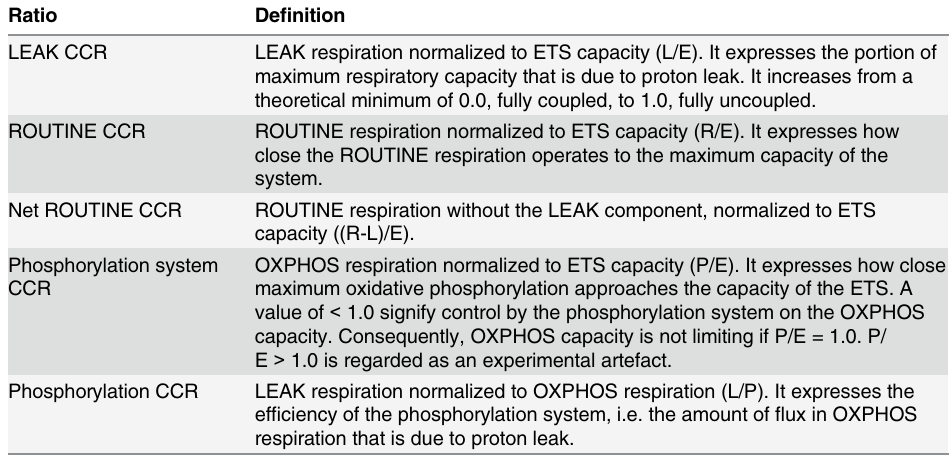
Table 2. Definitions of the coupling control ratios (CCRs) used.